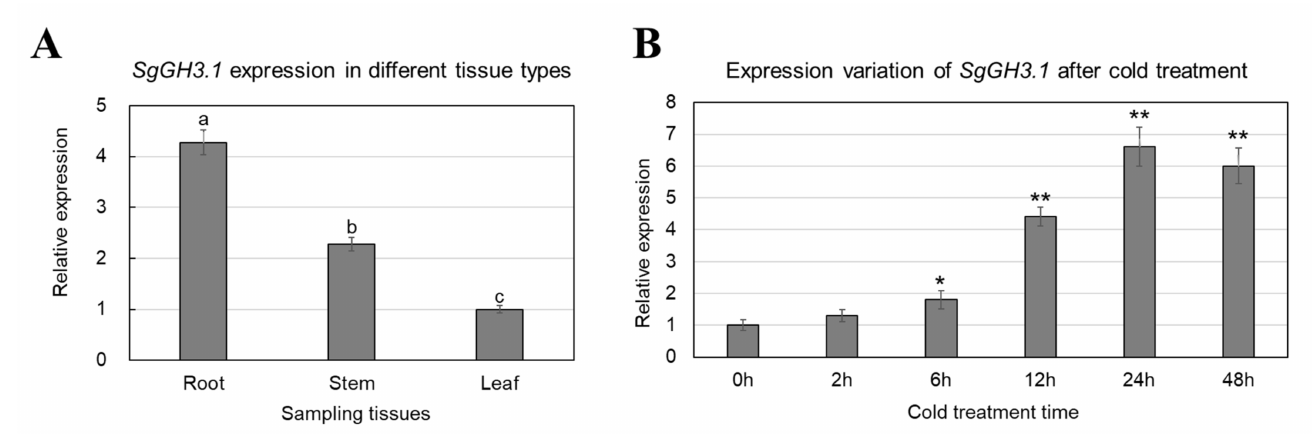
Figure 2. Expression of SgGH3.1 in different tissues of stylo ( A ) and expression variation of SgGH3.1 in leaf tissues of stylo after cold treatment ( B ). Different letters above the columns indicate significant differences at p < 0.01 between different tissues. * and ** indicate significant differences at p < 0.05 and p < 0.01 with 0 h, respectively.